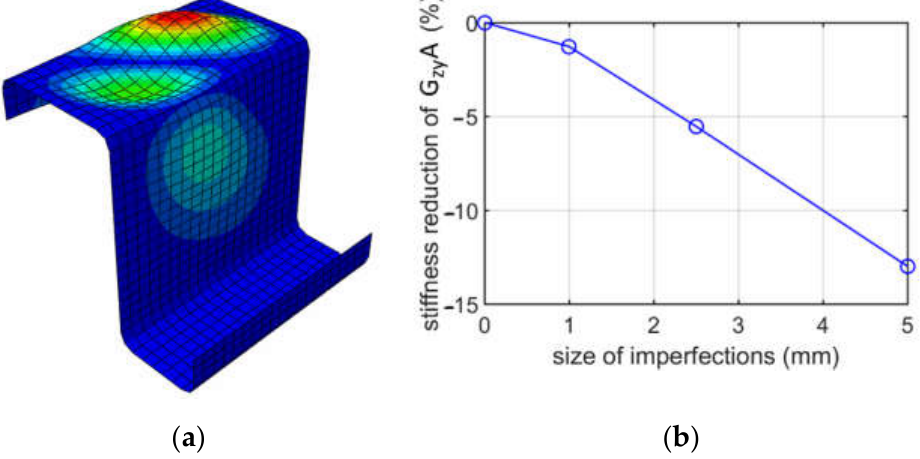
Table 8. Stiffness reduction of the Z profile with an elongation of 100 mm due to shearing for case (ii), depending on the size of imperfections.